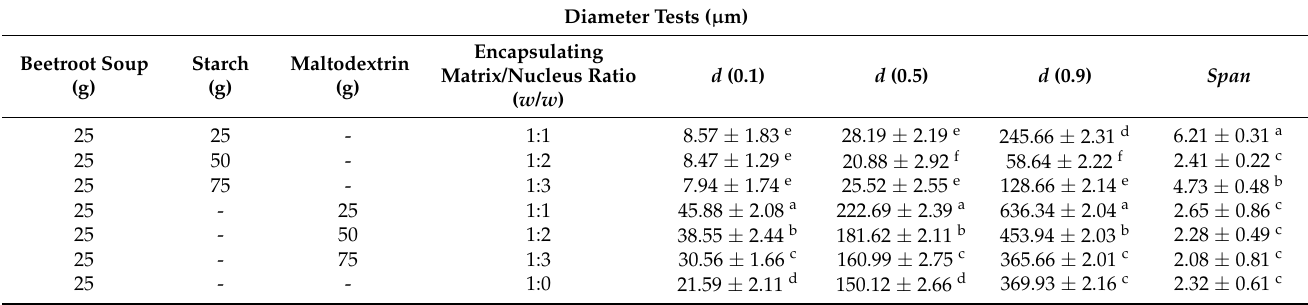
Table 1. Particle size distribution of beetroot soup microencapsulated by